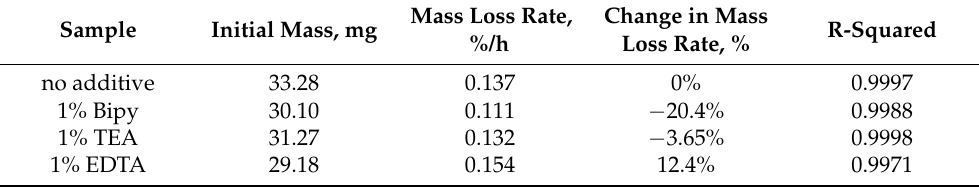
Figure 4. Isothermal TGA data for 90% aqueous HAN with and without additives in 1% concentra- tions. Table 2. 348 K Isothermal TGA test parameters and linear fit results for 1% additive